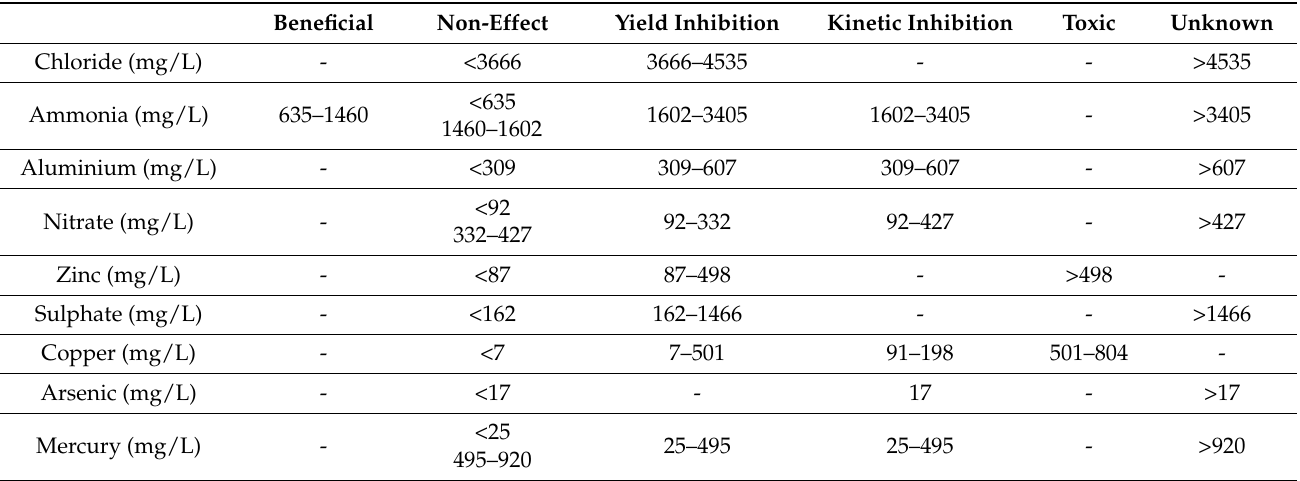
Table 3. Summary of concentration ranges impacting AD of sewage sludge obtained from BMP tests.